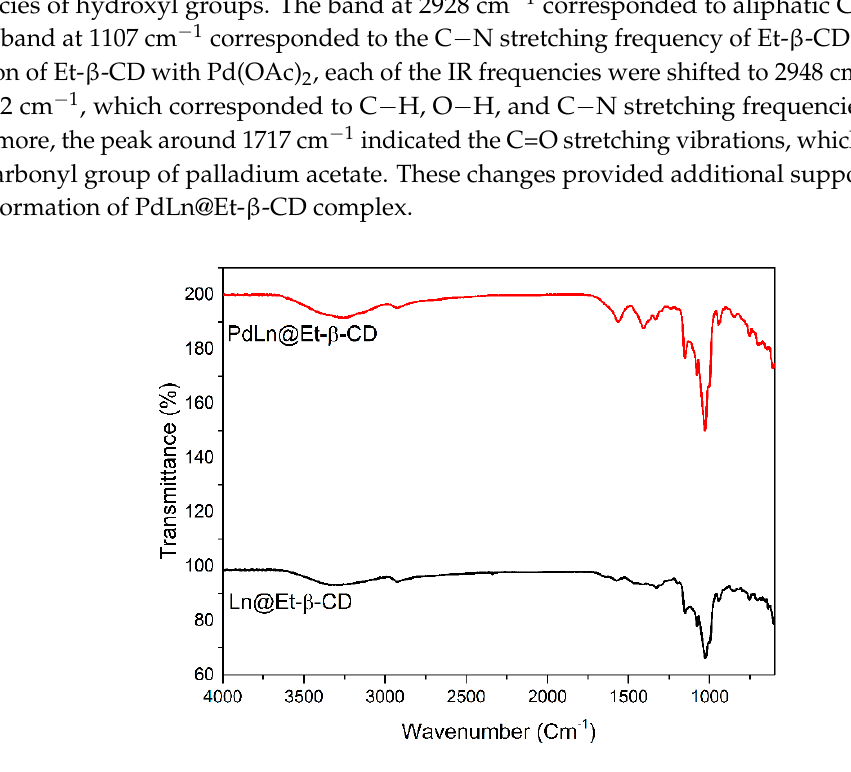
Figure 2. FT-IR spectra of Et- β -CD and PdLn@Et- β -CD. Figure 2. FT ‐ IR spectra of Et ‐β‐ CD and PdLn@Et ‐β‐ CD. Figure 2. FT ‐ IR spectra of Et ‐β‐ CD and PdLn@Et ‐β‐ CD.